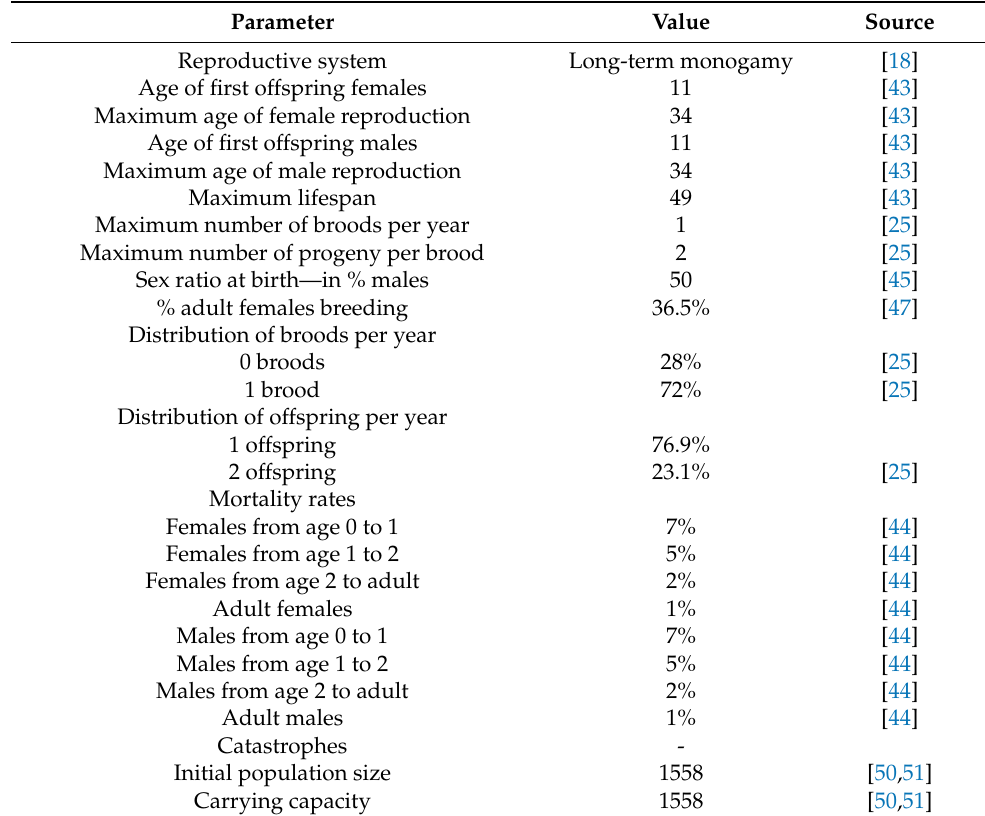
Table 1. Life history parameters used to model the viability of the blue-and-yellow macaw ( Ara ararauna ) population in Emas National Park, Brazil. For a detailed description of input parameters, see